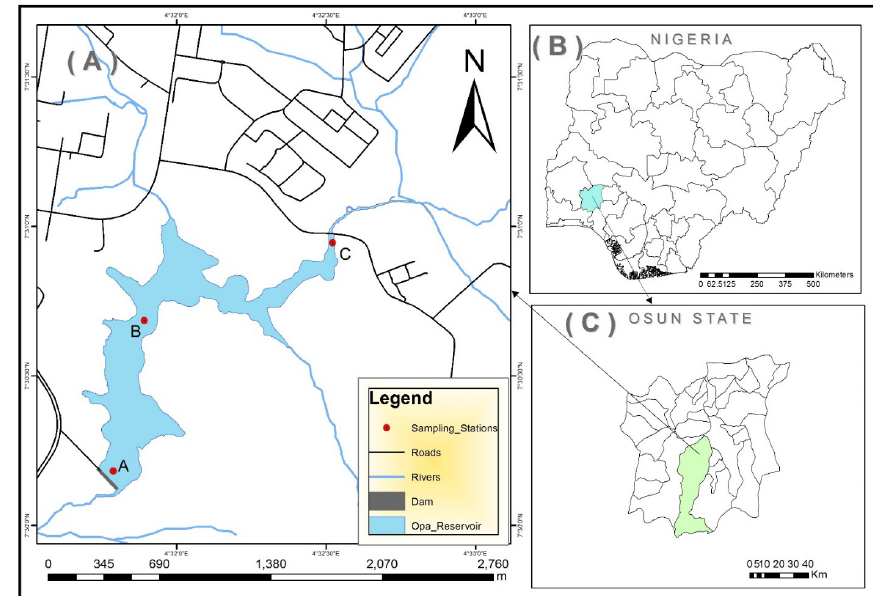
Fig. 1. Map of Opa Reservoir showing the investigated sampling stations (A); Nigeria (B); Osun State